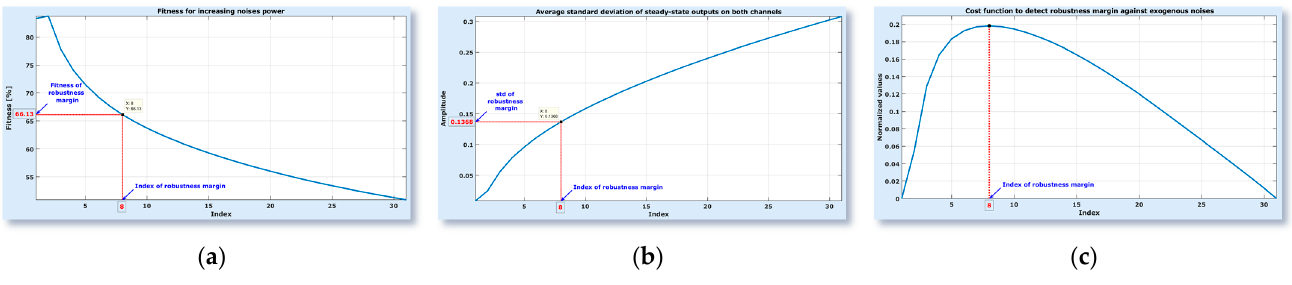
Figure 21. PID-ASTANK2 performance for switched references of the previous figure.